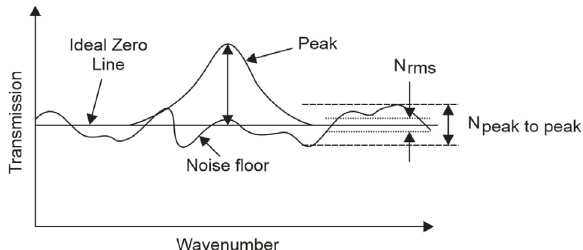
Figure 1. Noise influence analyses in transmission characteristics.